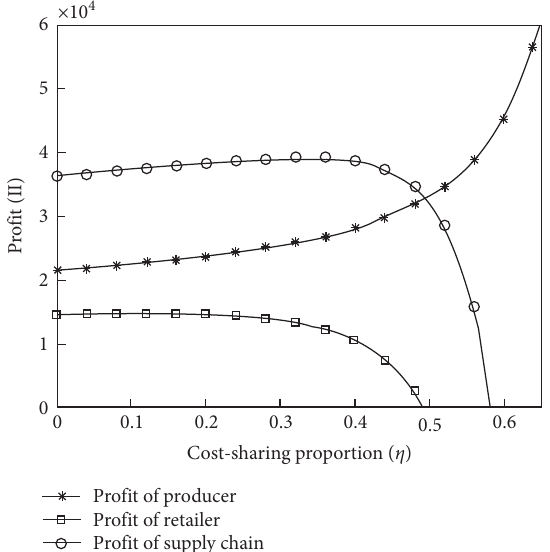
Figure 1: Impact of the cost-sharing proportion ( η ) on individual and channel